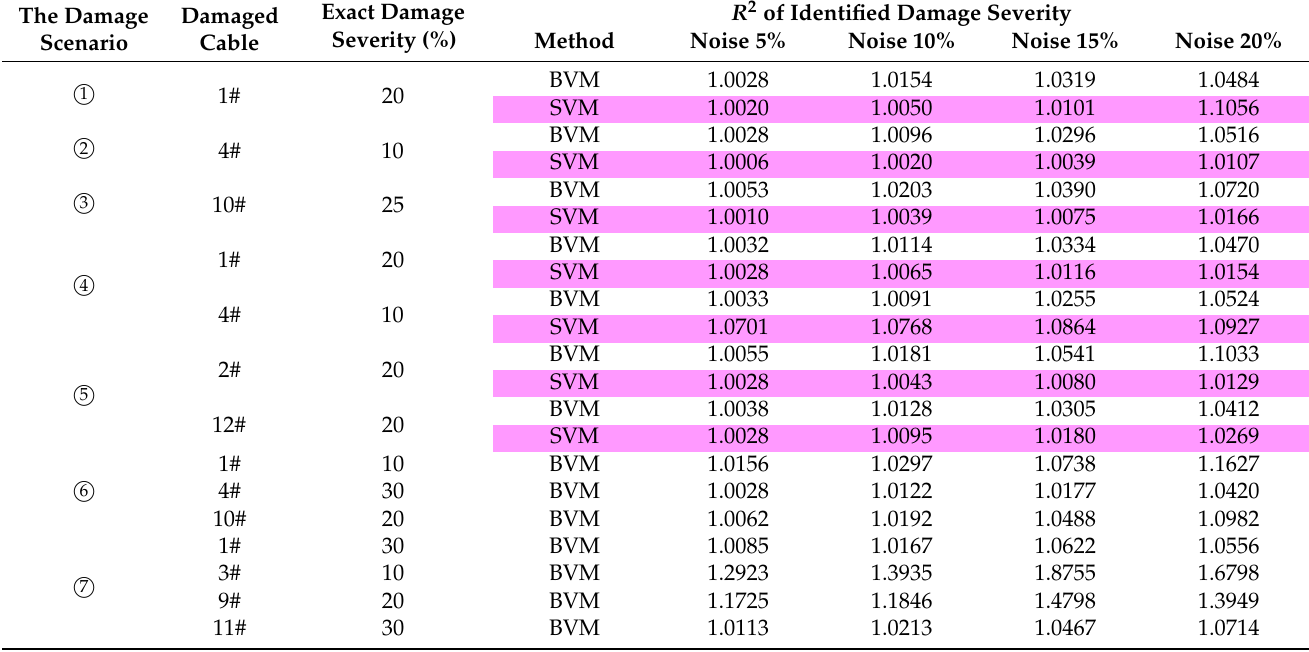
Table 8. The R 2 of the identified damaged severity of the 7 damage scenarios’ test dataset using the BVM method and the SVM method [18].